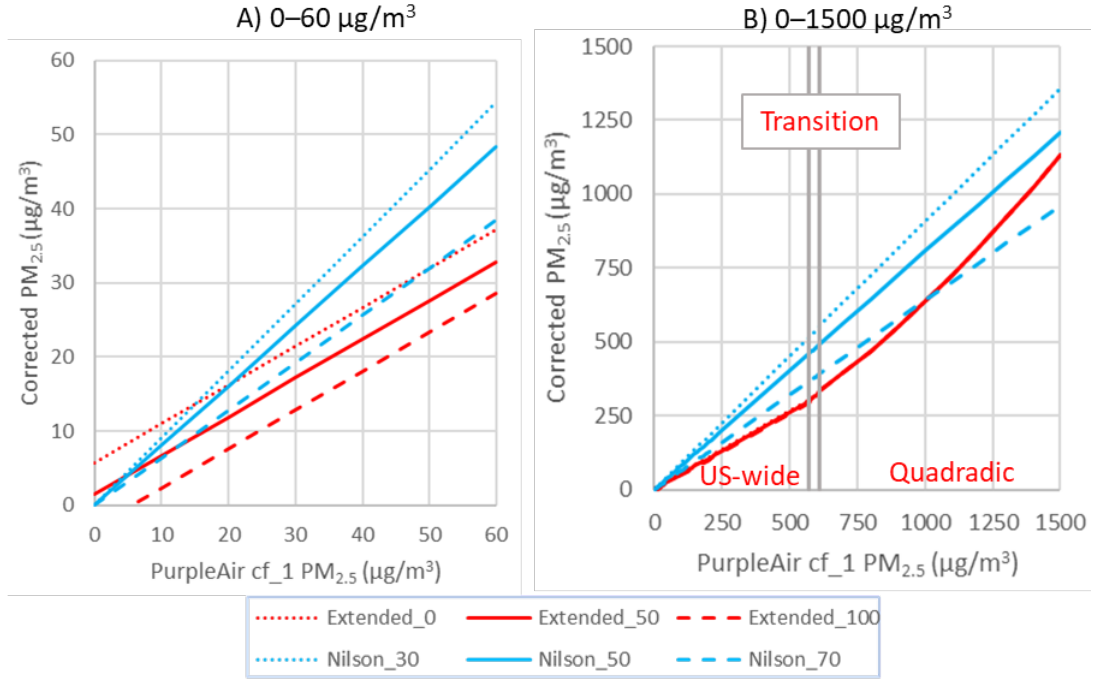
Figure 5. Disagreement between Nilson and the extended US-wide correction, plotted over the range of RH used in each correction, shown at low concentrations ( A ) and over the full range ( B ) with grey vertical lines showing the transition zone from the US-wide correction to the quadradic fit.